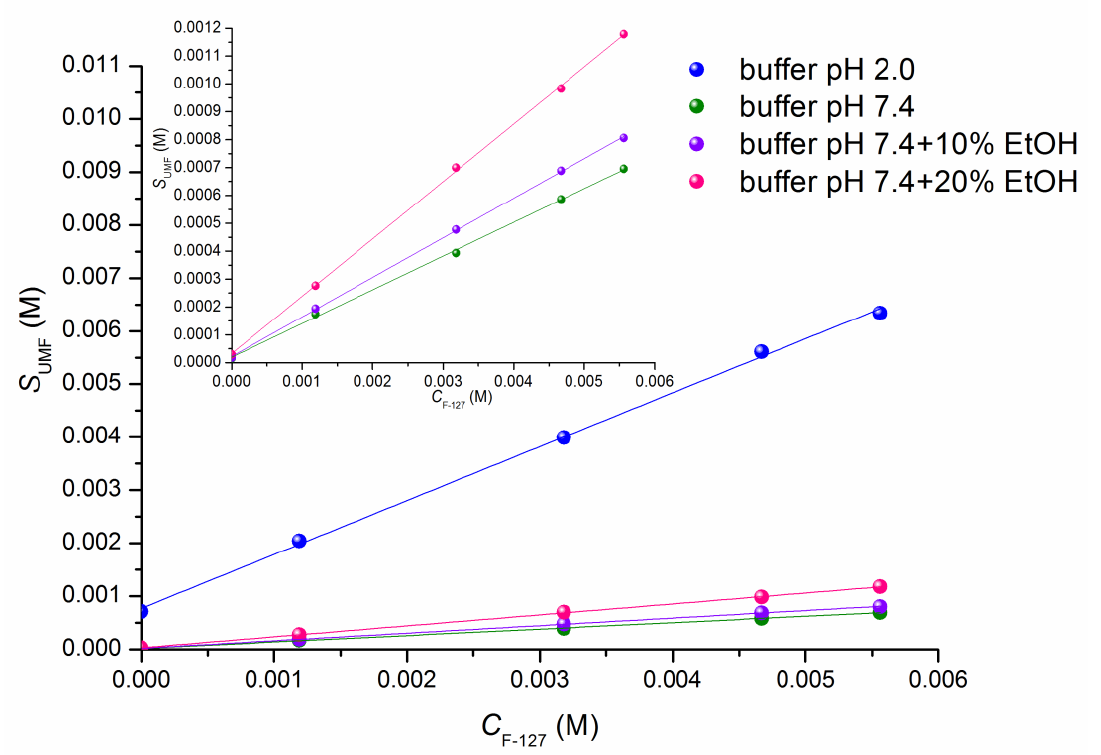
Figure 2. Solubility of UMF at different concentrations of F-127 (1.5–7.0%) in buffers pH 2.0 (blue) and pH 7.4 (olive) and in the presence of 10% (violet) and 20% (pink) ethanol (EtOH) at 310.15 K. Inserted plot illustrates the phase solubility of UMF in pH 7.4 and in the presence of 10% and 20% EtOH on a large scale.